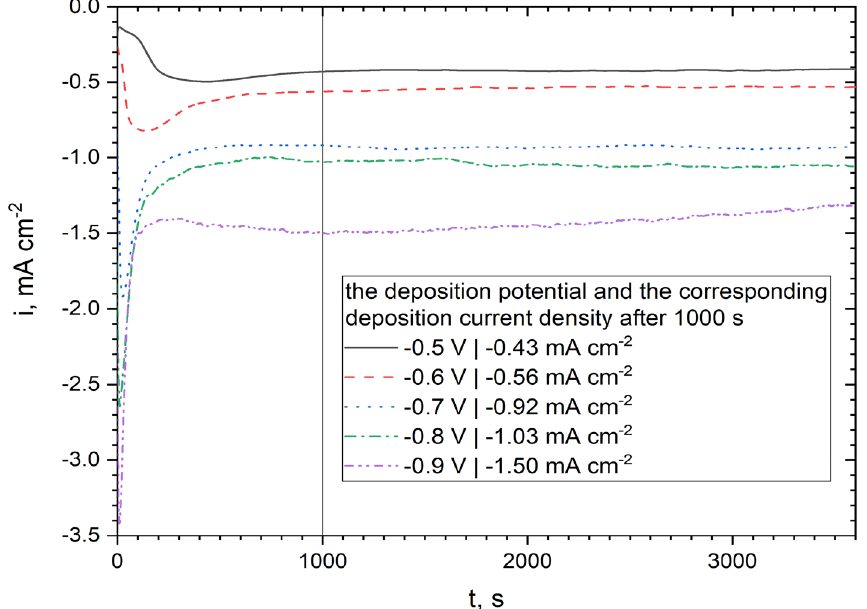
Figure 2. Current density vs. time dependences recorded on Cu base material during 1 h electrodeposition of Ni–Mo coatings at potentials of − 0.5 to − 0.9 V vs. Ag at 50 °C in the plating bath composed